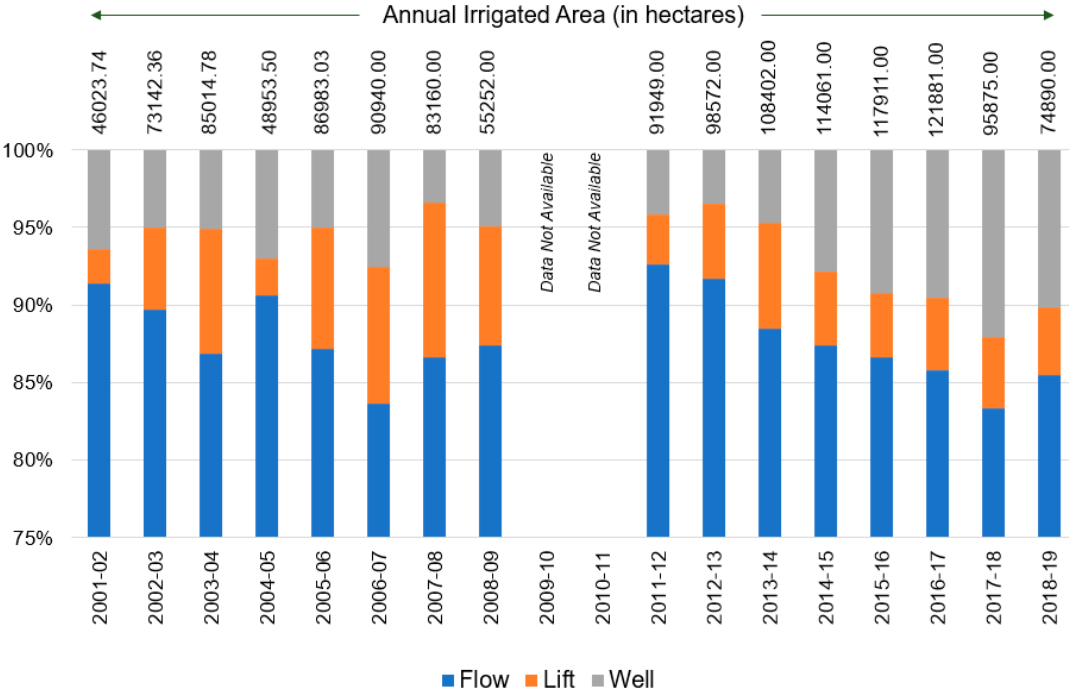
Figure 8. Irrigation trends in Pench command area, based on different irrigation methods. Information source: Reference [110].